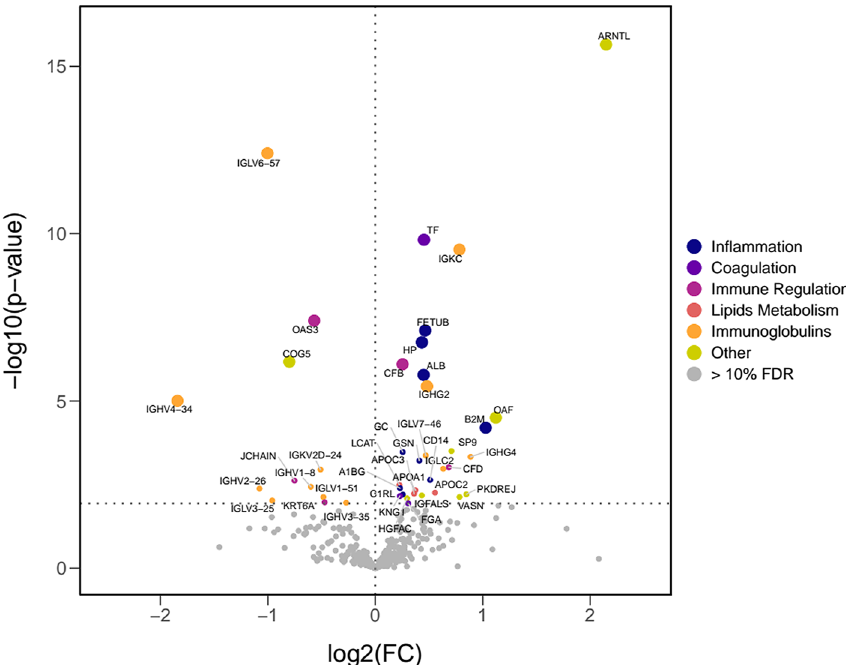
Figure 3. Volcano plot summarizing the results obtained from the differential expression analysis between critical and non-critical patients. X-axis represents the log2-transformed fold-change (FC). Y-axis shows the minus-log10-transformed p value associated to the protein in the comparison. Positive log2-fold-changes indicate over-expression in critical patients while negative log2-fold-changes represent over-expression in non- critical patients. Results were derived from a linear mixed-effects model fitted to each protein independently that included peptide and patient as random effects. Digestion batch, evolution group (critical/non-critical), blood extraction day and the interaction of the two latter were modelled as fixed effects. Comparisons were performed by averaging time point estimations within each evolution group. Statistical significance was assessed using a Wald test derived from the models. (Figure created using R version 3.6.0, https:// www.R- proje ct.